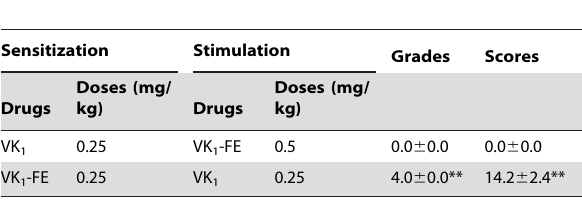
Table 6. Grades and scores for the symptoms presented by the dogs in a cross-challenge